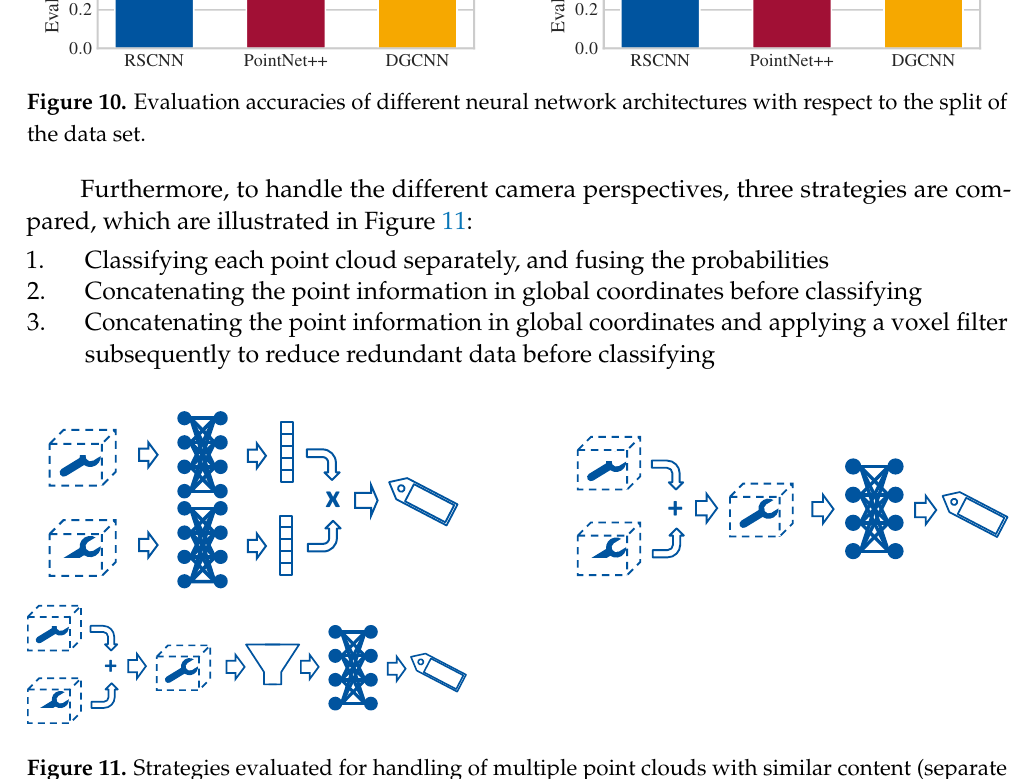
Figure 11. Strategies evaluated for handling of multiple point clouds with similar content (separate classification, concatenation, concatenation, and